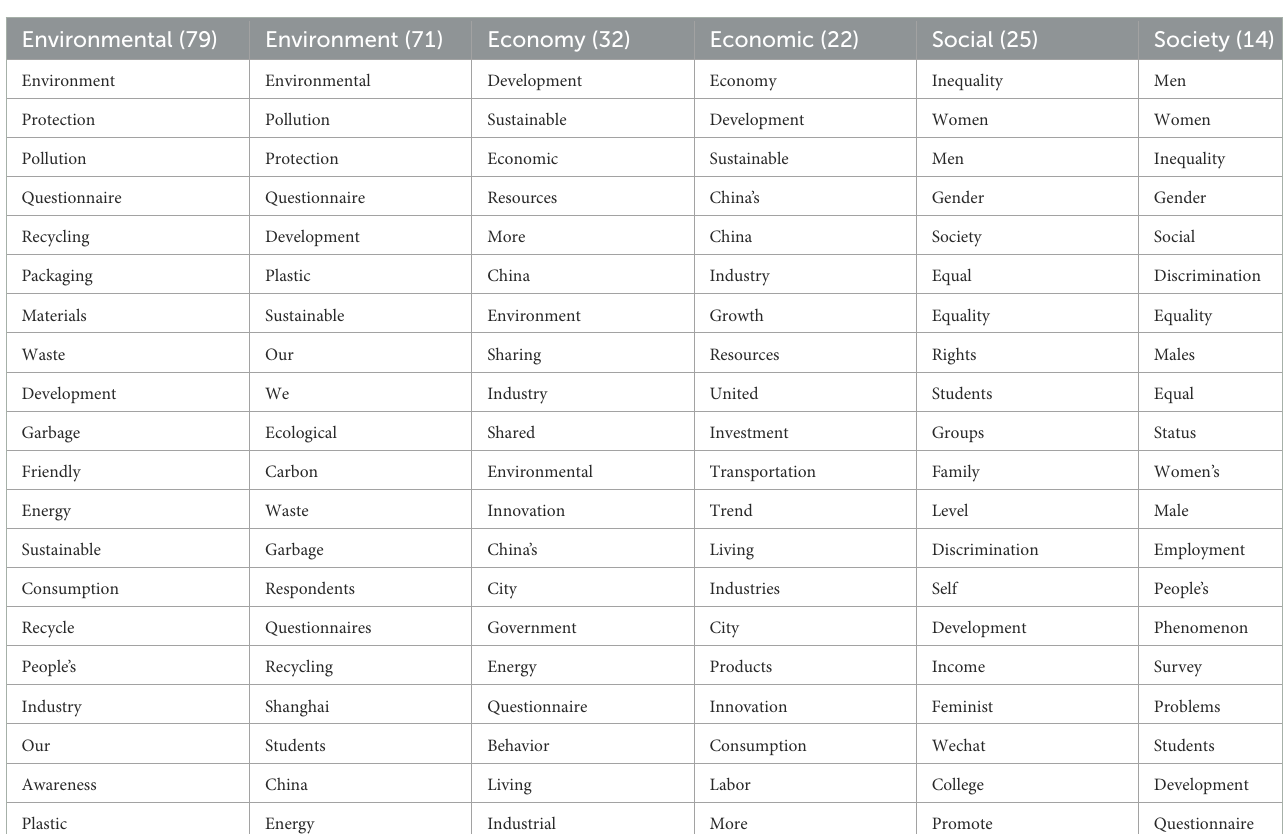
TABLE 2 Associate sets of sustainability